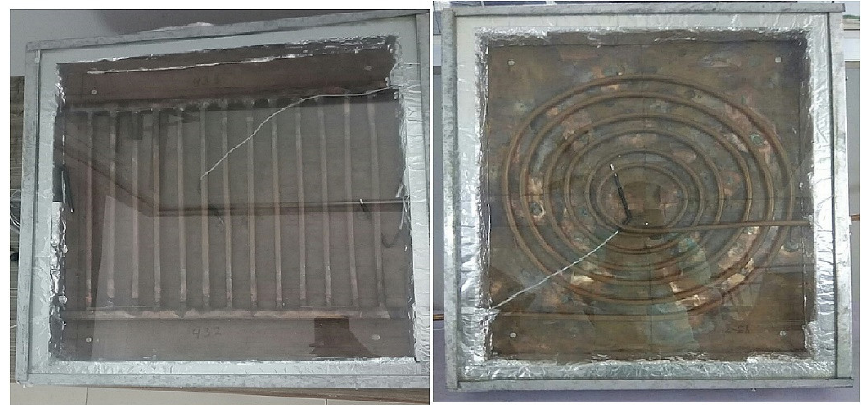
Figure 11. Thermal collector with harp and spiral design. Reprinted with permission from Ref. [41].